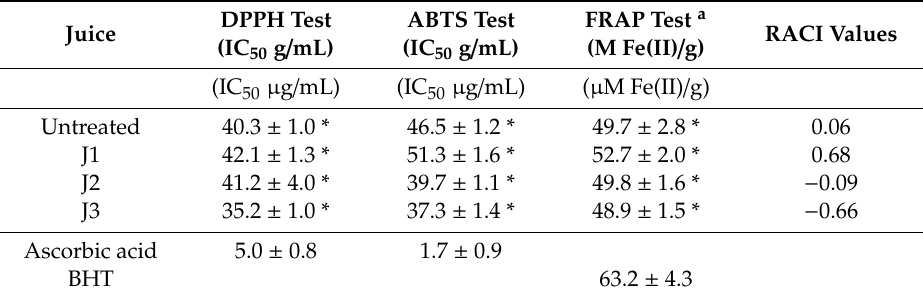
Table 3. Antioxidant activity of untreated and UF C. limon juice.